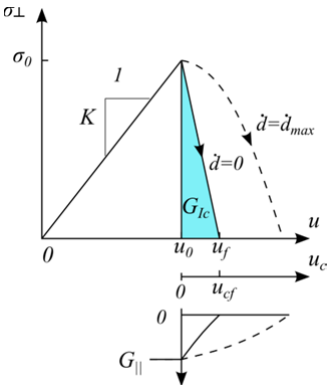
Fig. 8 Crack delay model: tensile stress for Mode I cracking in function of relative nodal displacement and crack opening displacement; Shear stiffness reduction in function of crack opening